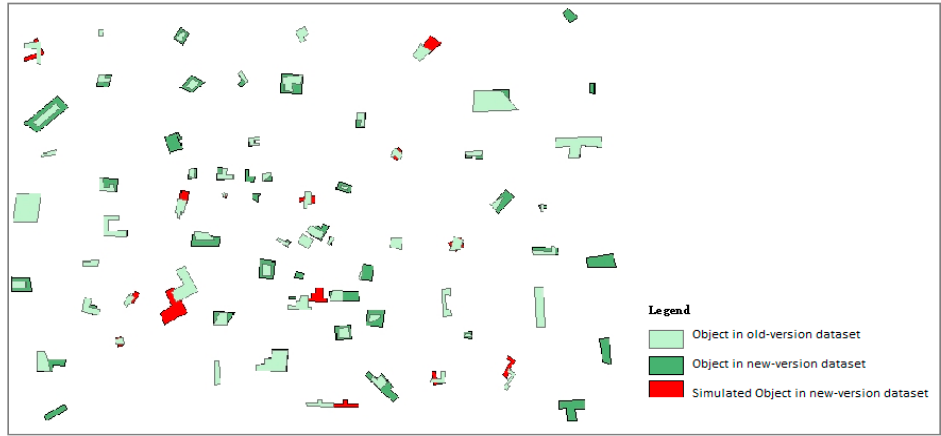
Figure 6. Illustration of change samples from both old and new dataset. Table 5. Detection result of change type in study area.